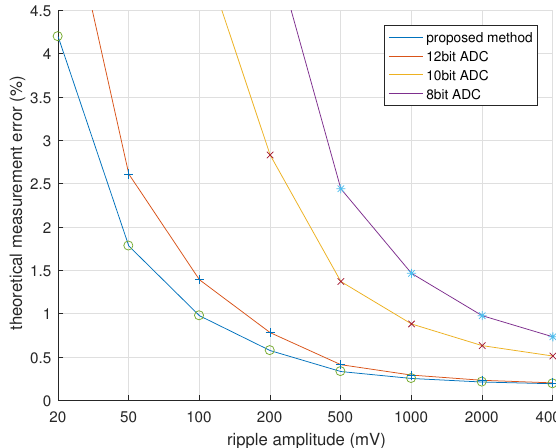
Figure 8. The theoretical measurement errors of different methods.